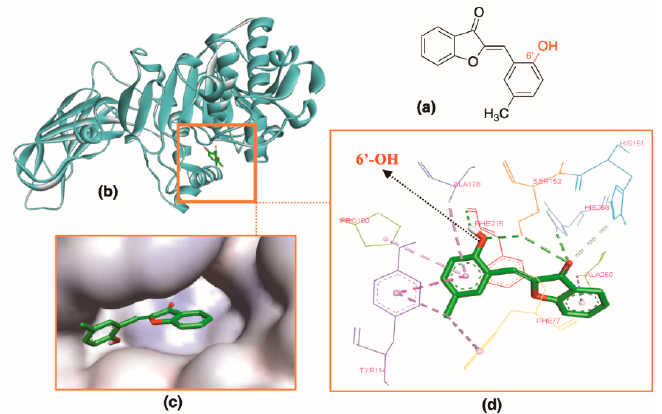
Figure 5. Docking result of A11 with protein (PDB ID: 1LPB): ( a ) 2D structure of A11 . ( b ) A11 inside